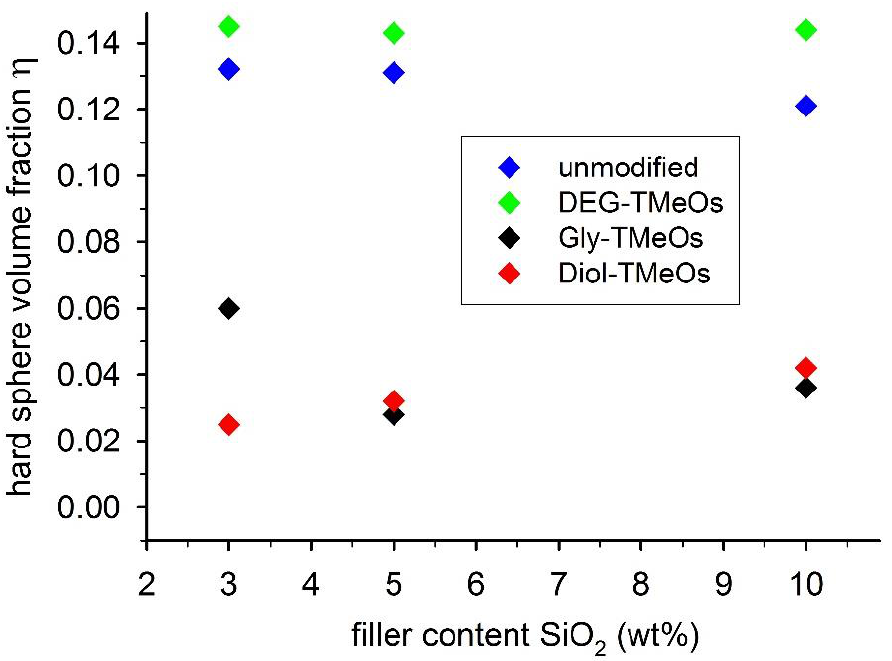
Figure 7. Hard sphere volume fraction of ZrO 2 nanoparticles with different surface modifications and incorporated into the epoxy resin matrix with different percentages.